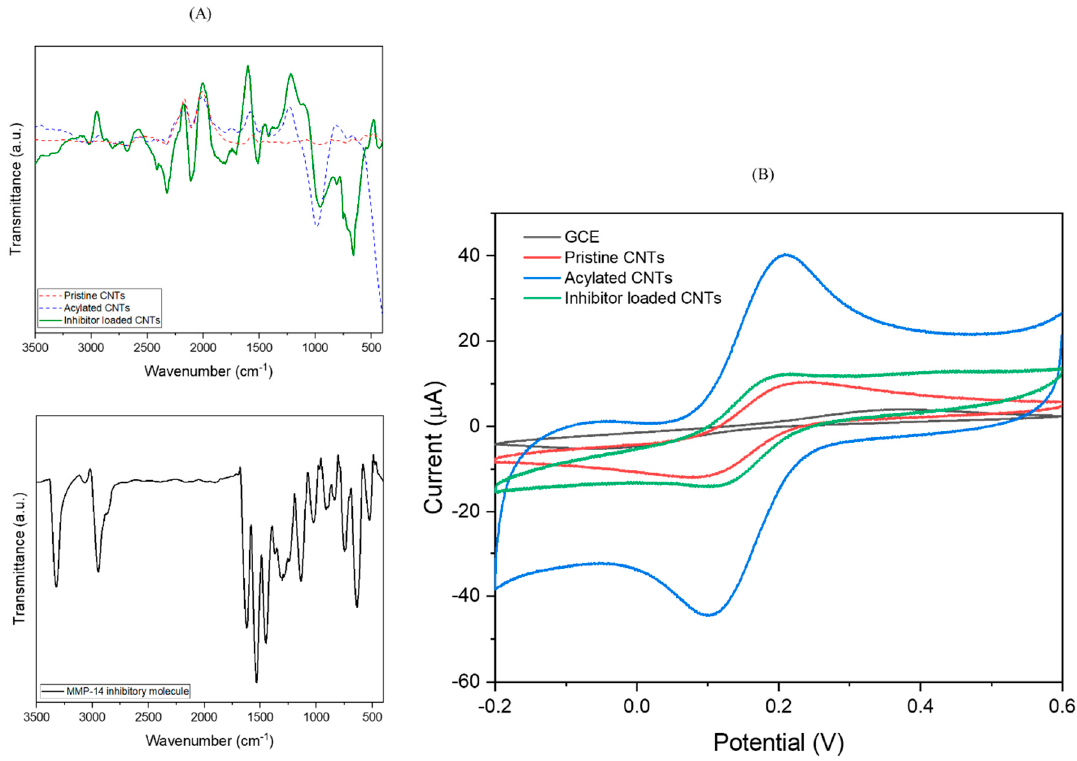
Figure 2. ( A ) FTIR spectrum (top) of pristine, acylated, and inhibitor loaded CNTs, respectively. The spectrum (down) of NSC 405020 molecule is also demonstrated. ( B ) CVs for GCE, pristine, acylated, and inhibitor loaded CNTs in PBS (pH 7.40) containing 10 mmol · mL − 1 of K 4 [Fe (CN) 6 ] − , 10 mmol mL − 1 of K 3 [Fe (CN) 6 ] − and 10 mmol.mL − 1 of NaCl, scan rate 10 mV.s − 1 . After grafting the inhibitor on CNTs, additional peaks were observed at ~3012, 1513 and 1412 cm − 1 , assigned to C–C and C=C vibration of the benzene ring [65–67]. The strong peak at ~675 cm − 1 is characteristic of C–Cl bond present in the chlorobenzene [65,68]. The peak at ~1704 cm − 1 is associated with N–H stretching from the molecule structure [69]. neighboring atom, some peaks have shifted from the expected wavenumber, such as C–Cl (~730 cm − 1 ) and N–H (~1610 cm − 1 ). Cyclic voltammetry was carried out with ferro- cyanide/ferricyanide redox couple (Fe (CN) 63 − /4 − ) to confirm the presence of inhibitor on CNTs (Figure 2B). An increase in peak current density ( I pa = ~10.30 µ A), and a decrease of peak width ( ∆ E p = ~134 mV) was observed in the Fe (CN) 63 − /4 − voltammograms after